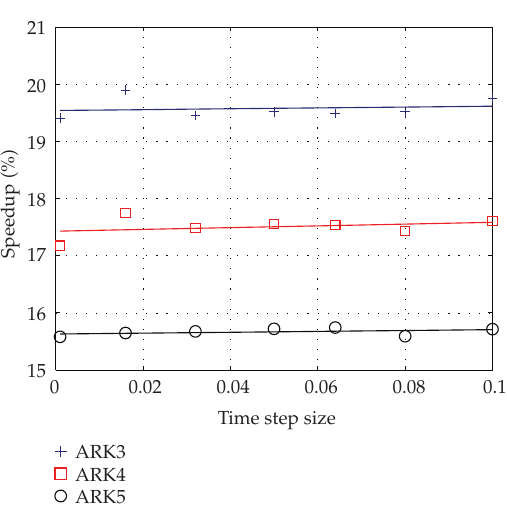
Figure 9: Speedup of ARK methods compared with RK methods for IVP-2.